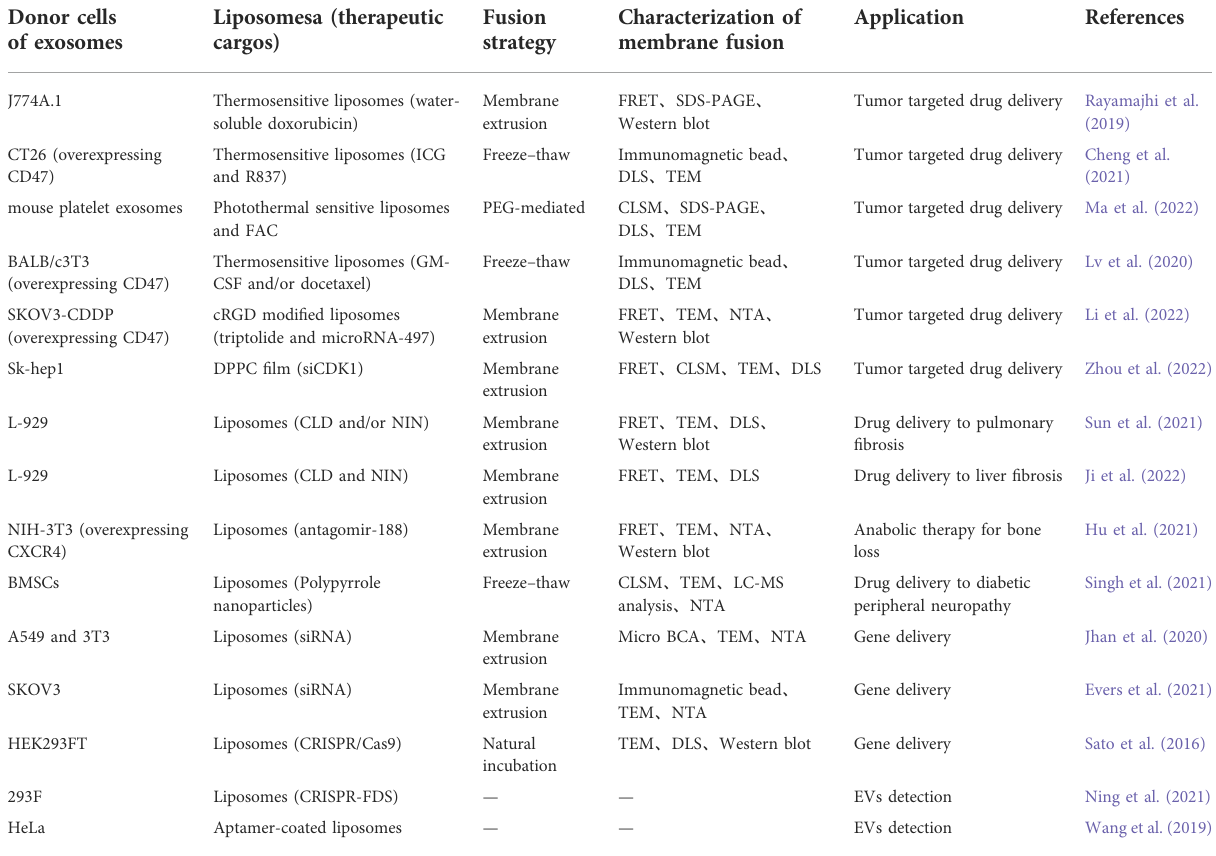
TABLE 2 Overview of various strategies employed to produce MFHEs as well as the